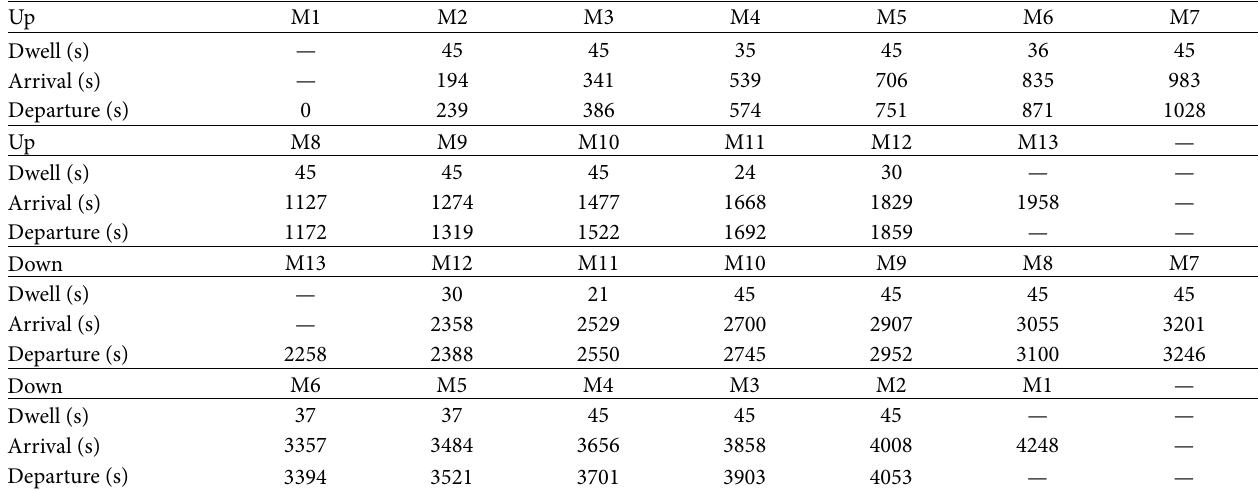
Table 12: The optimized timetable for the first train of the